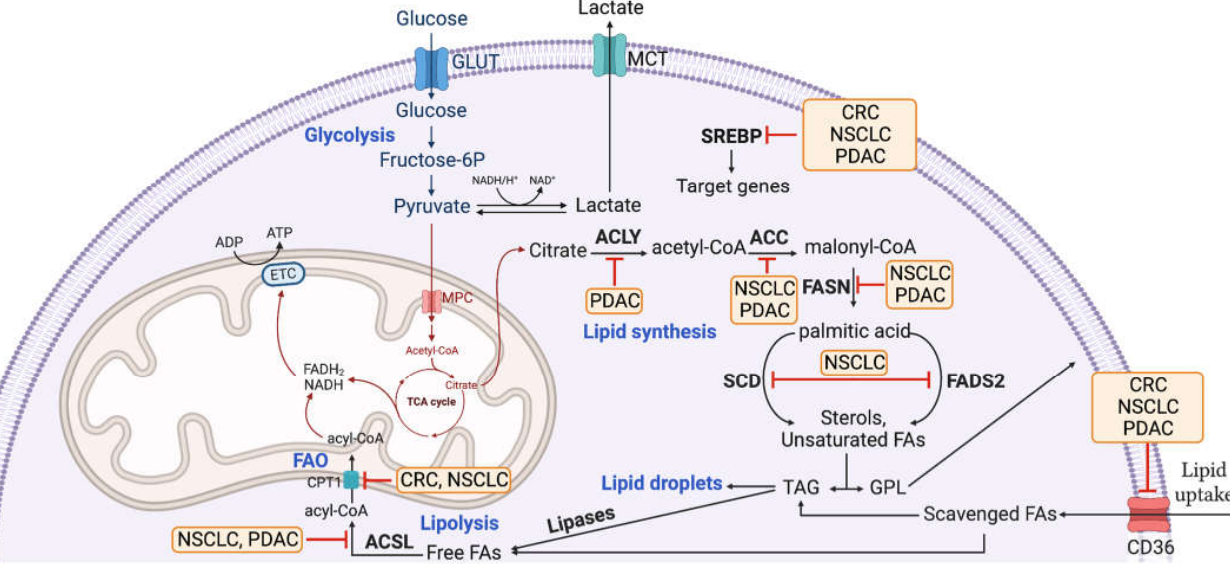
Figure 1. Schematic representation of FA uptake, synthesis and oxidation and the related actionable targets in different KRAS-driven cancer types. The red arrows indicate actionable targeted approaches that result in reduced tumor growth/increased cell death. The cancer types where these strategies are successful are highlighted in orange. PM: plasma membrane; CRC: colorectal cancer; NSCLC: non-small cell lung cancer; PDAC: pancreatic ductal adenocarcinomas; SCD: stearoyl-CoA desaturase; FADS2: fatty acid desaturase 2; GLUT: glucose transporter; MCT: monocarboxylate transporter; ACLY: ATP citrate lyase; ACC: acetyl-CoA carboxylase alpha; SREBP: sterol regulatory element binding transcription factor; TAG: triacylglycerols; GPL: Glycerophospholipids; CPT1: carnitine palmitoyltransferase 1A; FAO: fatty acid oxidation; ACSL: acyl-CoA synthetase long chain